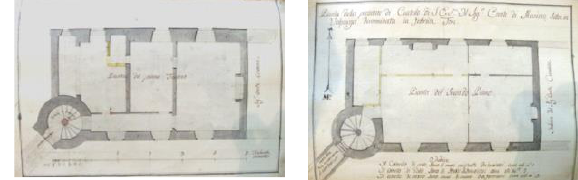
Figure 6. Pianta della prosione di Castello […], 1807. ASCM, faldone 375/n° 6637.